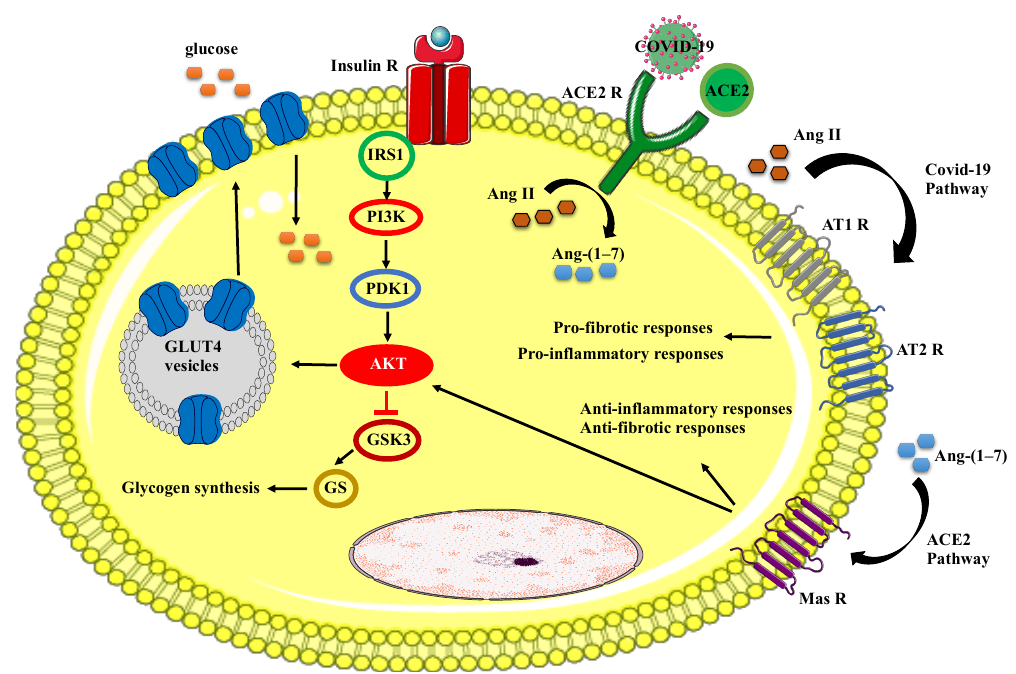
Figure 1. COVID-19 mechanism of action. Phosphorylation of Akt leads to the translocation of Glut4 to the cell membrane, which facilitates glucose uptake. ACE2 induces anti-fibrotic and anti-inflammatory responses and activates Akt through the Mas receptor. COVID-19 activates AT1 and AT2 receptors, which results in the generation of pro-fibrotic and pro- inflammatory responses in the cell. Insulin R: insulin receptor, IRS1: Insulin Receptor Substrate 1, PI3K: Phosphoinositide 3-kinase, PDK1: Phosphoinositide-dependent kinase-1, GSK3: Glycogen synthase kinase, GS: Glycogen synthase, ACE2 R: ACE 2 receptor, Mas R: Mas receptor.